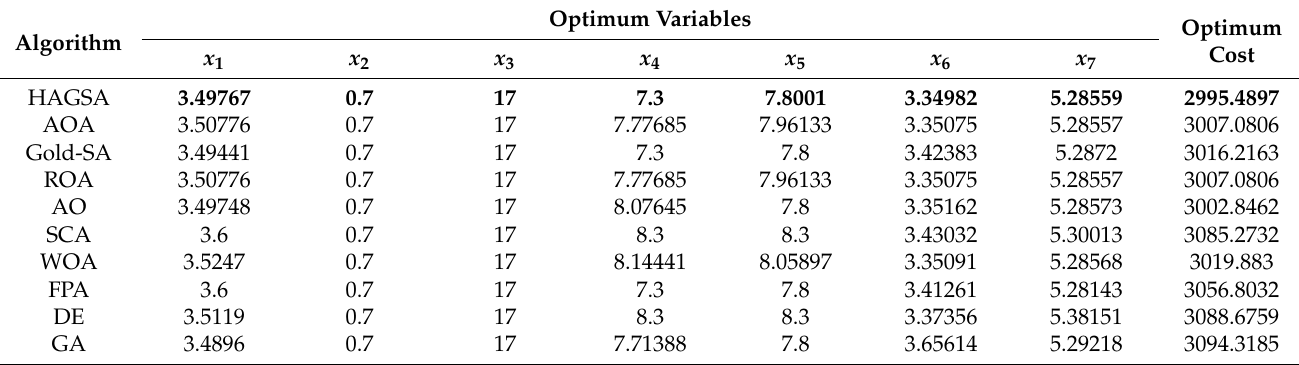
Table 9. Statistical results of the speed reducer design problem.